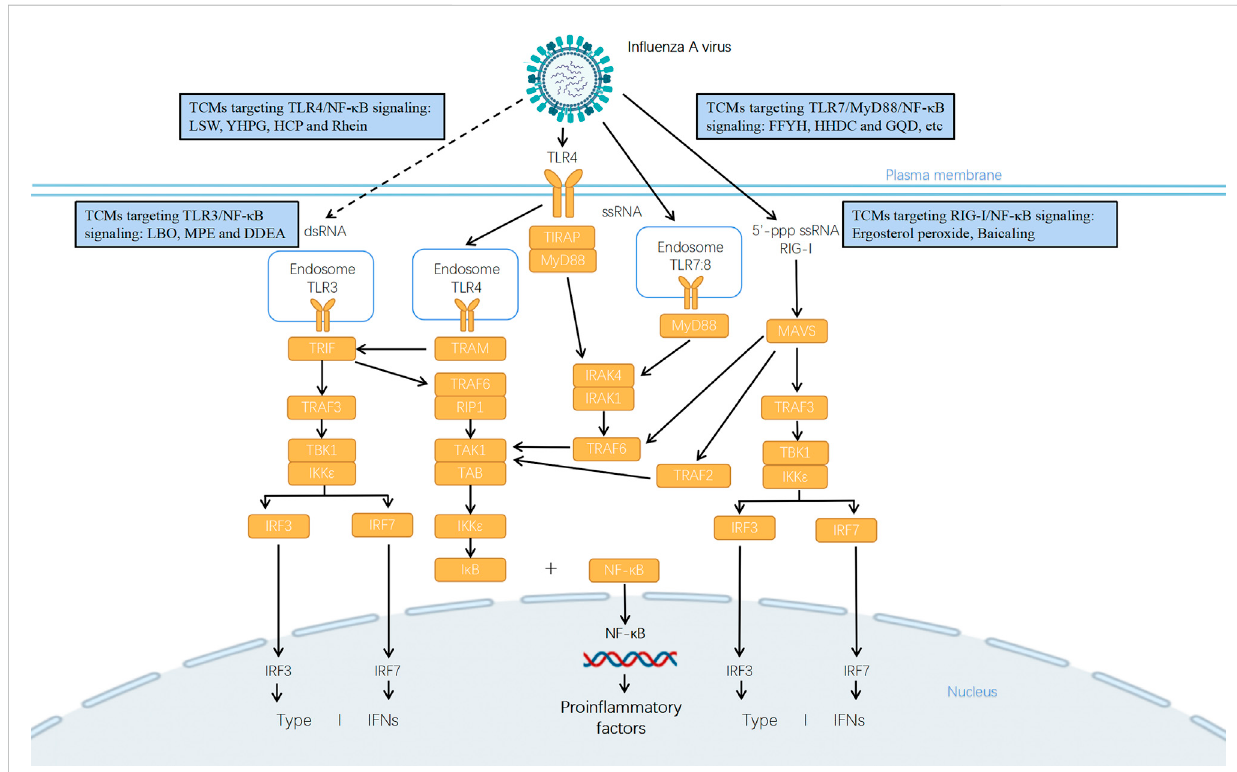
FIGURE 1 Potential mechanisms of anti-in fl uenza TCMs in treatment of in fl uenza pneumonia via TLRs/RIG-I signaling pathway. In fl uenza virus infection is detected by multiple PRRs such as TLRs and RIG-I. TLR3 recruits TIR-domain-containing adapter-inducing interferon- β (TRIF) and the endocytosed TLR4 recruits TRIF and TRIF-related adaptor molecule (TRAM), which activates TRIF-dependent pathway. The interaction between TRIF and TNF receptor-associated factor 6 (TRAF6) recruits the receptor-interacting protein 1 (RIP1) and activates the transforming growth factor β -activated kinase 1 (TAK1)/TAK1-binding protein (TAB) complex that leads to activation of NF- κ B and downstream transcription of pro-in fl ammatory genes. Alternatively, TRIF interacts with TRAF3 and recruits TANK (TRAF family member associated NF- κ B activator)-binding kinase 1 (TBK1) and the inhibitor of NF- κ B (I κ B) kinase ε (IKK ε ), which drives the phosphorylation of the interferon regulatory factor 3 (IRF3) or IRF7 and downstream production of type I interferons(IFNs).TLR3recognizesdsRNAinendosomes,butitrecognizescurrentlyunknownRNAstructurespresentinginin fl uenzavirus-infectedcells (presented in dotted line). TLR4, TLR7, and TLR8 initiate downstream signaling through the adapter protein myeloid differentiation primary response differentiation gene 88 (MyD88)-dependent pathway. For TLR4, it uses TIR domain containing adaptor protein (TIRAP) as additional adapter in this pathway. TLR7 recognizes the ssRNA genomes of in fl uenza virus taken up into the endosome. The activation of MyD88 leads to the phosphorylation of IL-1R-associatedkinases1and4(IRAK1/4)whichbindswithTRAF6tomediatetheactivationofTAK1/TABcomplex,andtheninducesthetranslocationof NF- κ B to regulate the expression of cytokines and chemokines. RIG-I mainly recognizes viral nucleocapsids and viral genomic RNA bearing 5 ′ -ppp. It connectstoMAVSwhichthenassembleswithTRAF2/3/6,TBK1,andIKKcomplextofunctionasasignalinghubthatdrivestheactivationofIRF3,IRF7,and NF- κ B and downstream production of IFNs and proin fl ammatory cytokines and chemokines. A variety of TCMs could regulate the expression of key components in TLRs/RIG-I signaling pathways so as to inhibit viral replication and virus-induced pro-in fl ammatory